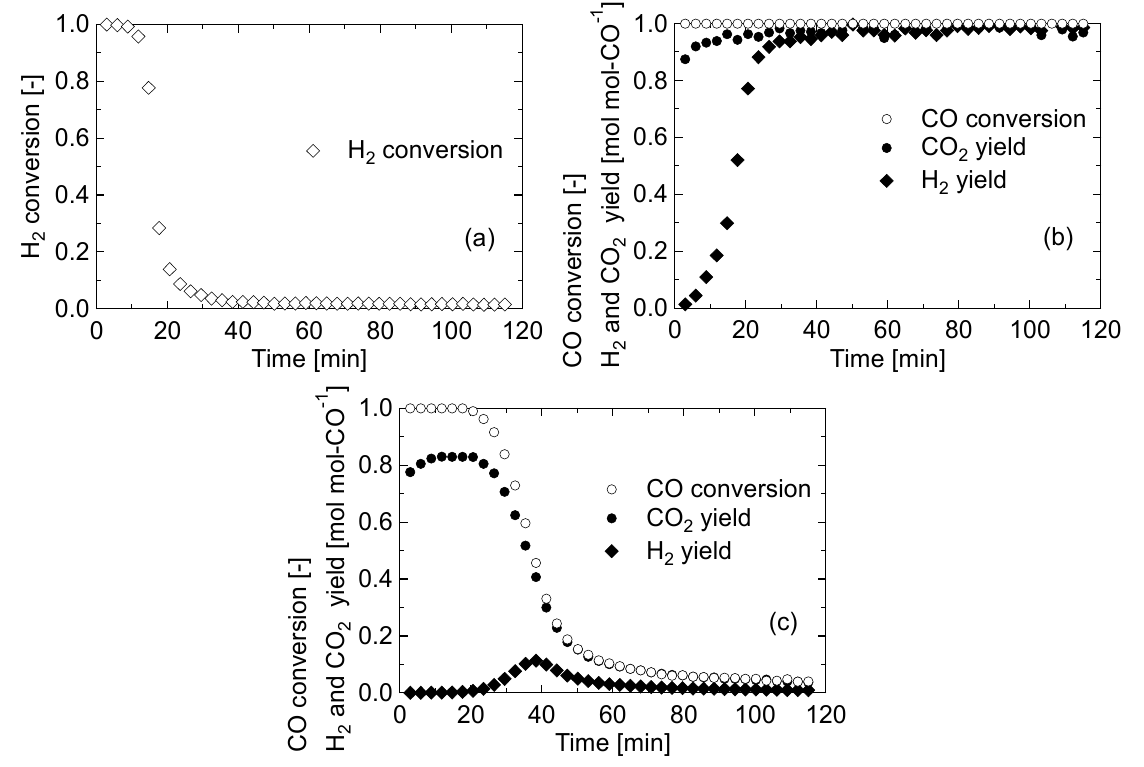
Figure 2. Product gas during pre-reduction of Au/Fe conversions of CO or H ( b ) CO/H O and ( c ) 2